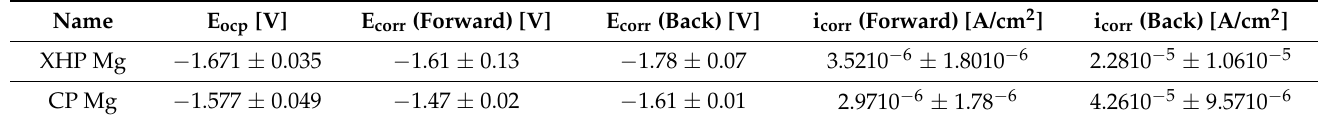
Table 3. Electrochemical measurement results, static conditions.